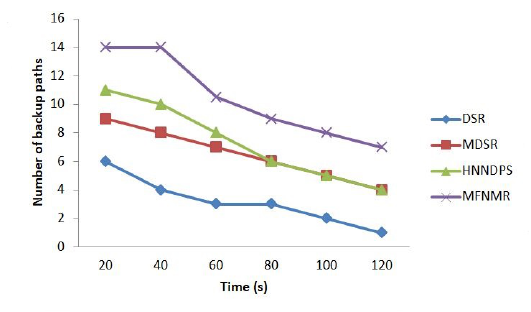
Figure 19. Backup Paths Analysis based on Time.